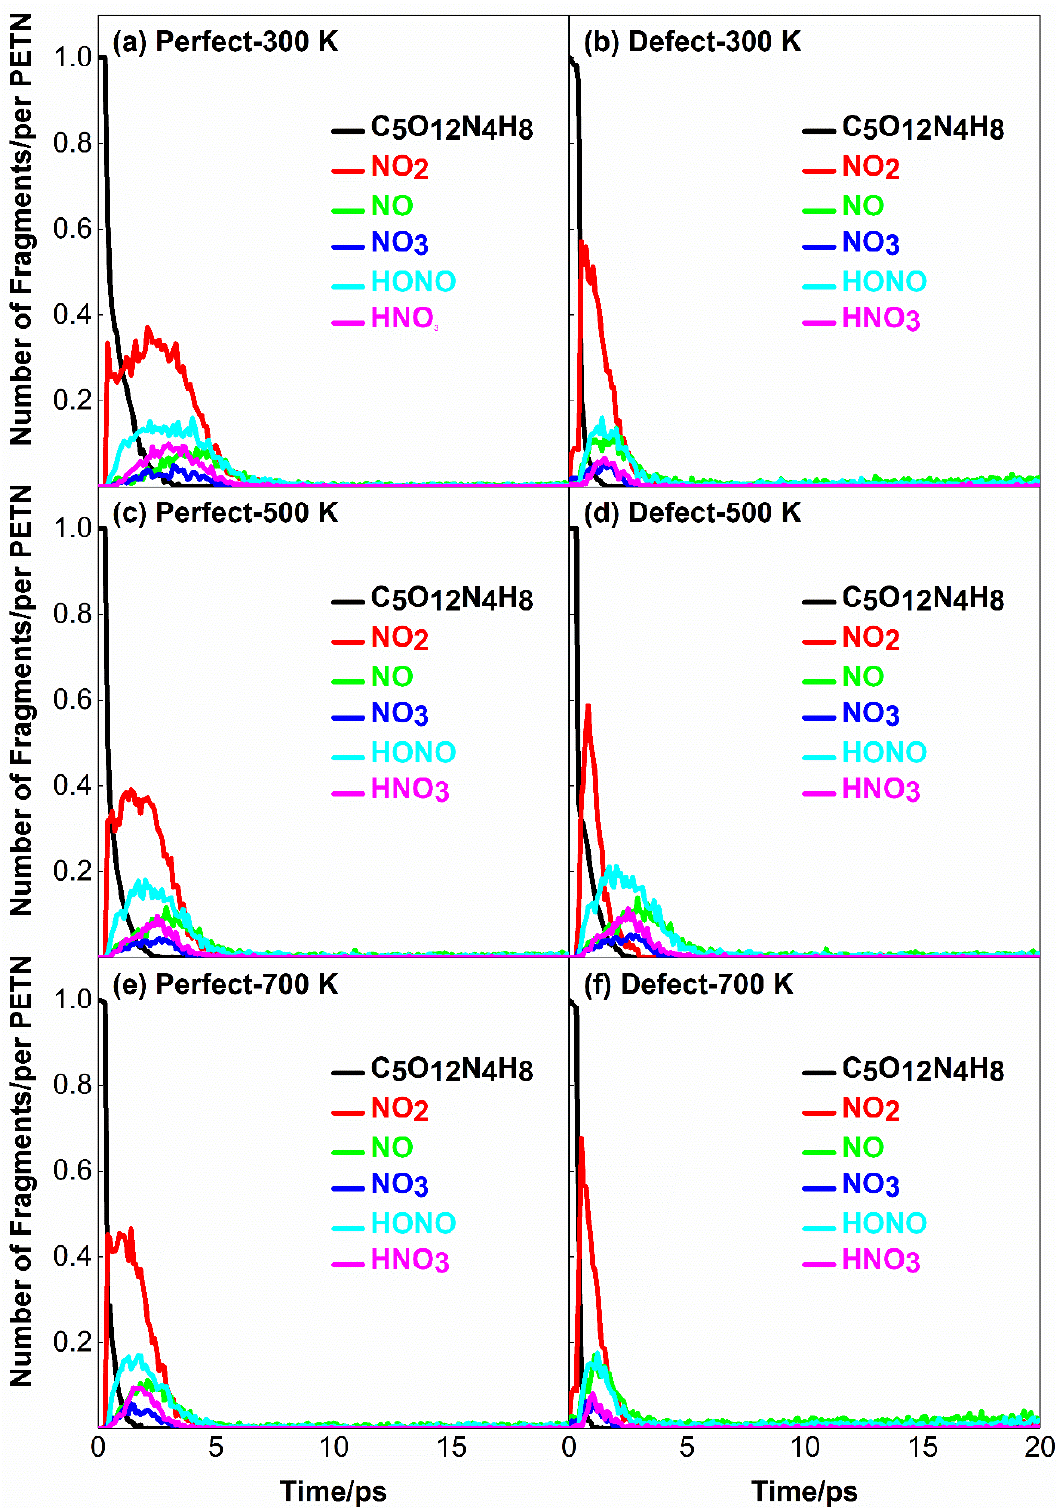
Figure 7. Time − dependent curves of initial decomposition products for the case of U s = 10 km·s − 1 . ( a , c , e ) correspond to perfect PETN crystal with preheating temperatures 300 K, 500 K, and 700 K; ( b , d , f ) correspond to defective PETN crystal with preheating temperatures 300 K, 500 K, and 700 K.